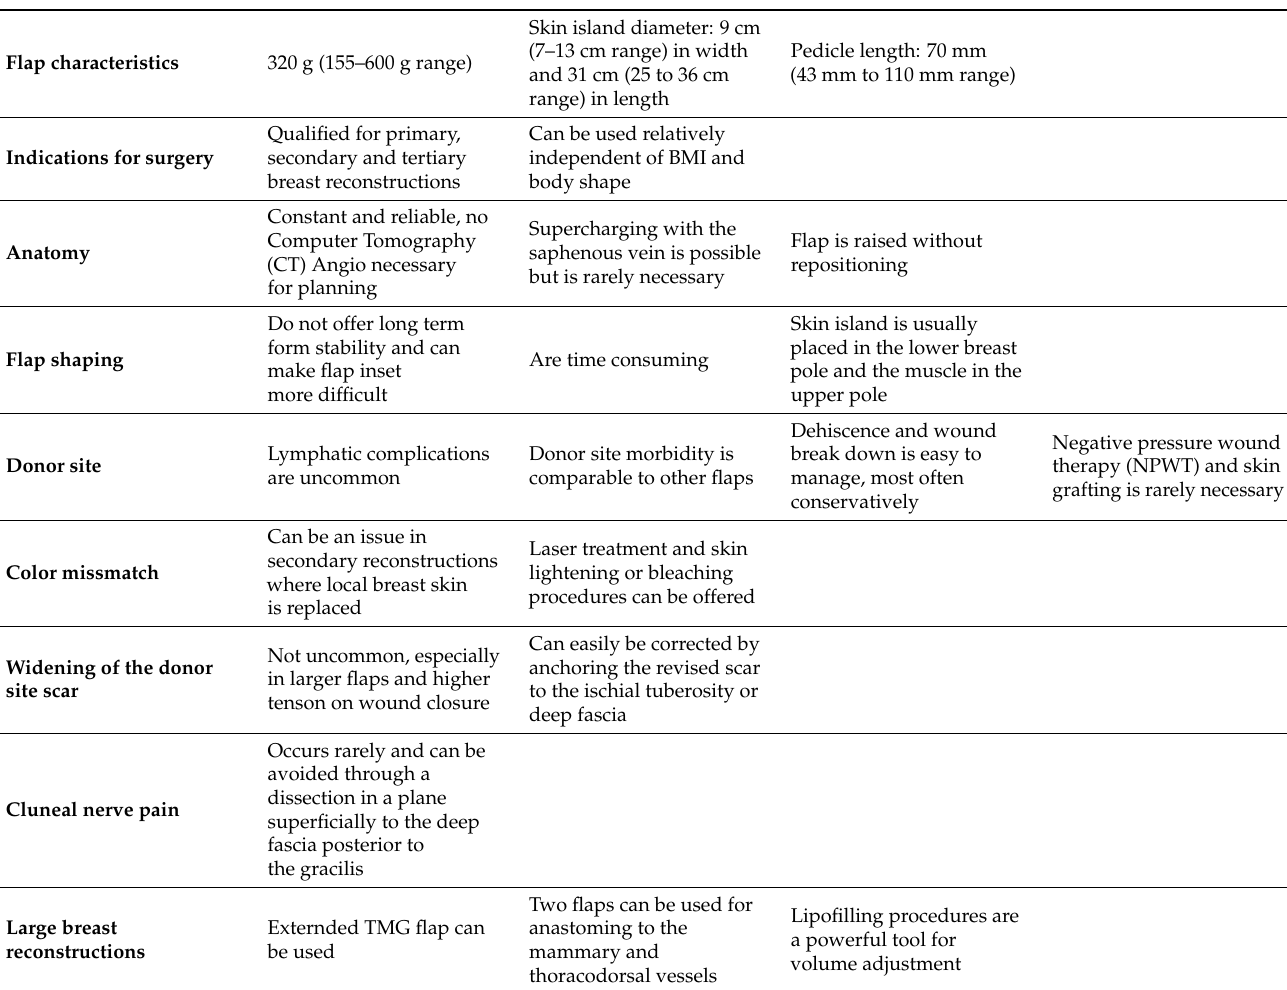
Table 6. Overview of key lessons learned in the last 30 years of TMG flap breast reconstruction.